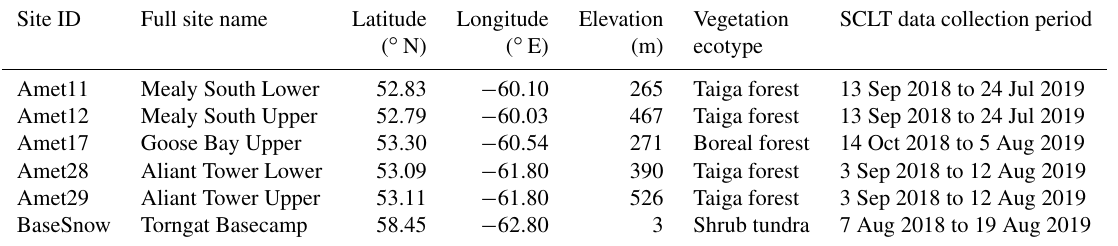
Table 1. Site specifications for the six SCLT sites including site name, latitude, longitude, elevation, ecotype and SCLT data collection period. Site